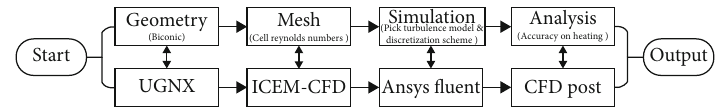
Figure 1: The process of CFD simulation.